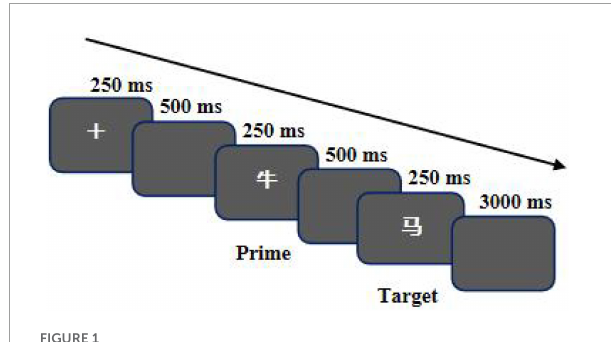
FIGURE1 Temporal sequence of events in semantic priming